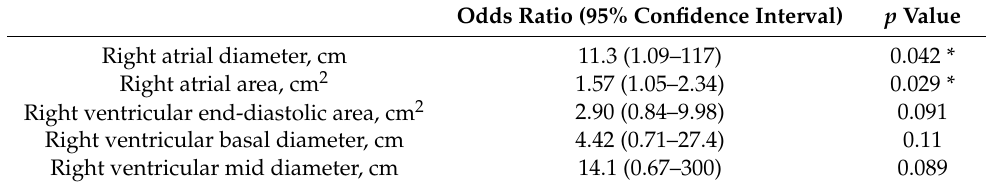
Table 2. Echocardiographic right heart parameters associated with procedure time > 60